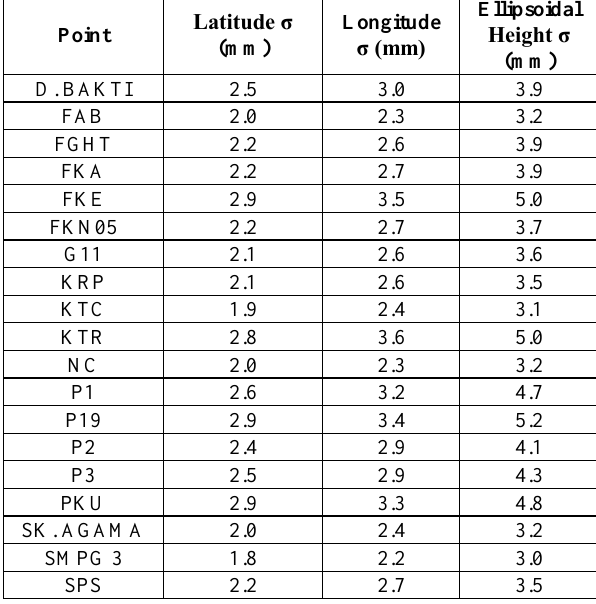
Table 5. Standard deviations of latitude, longitude and ellipsoidal height for one sigma